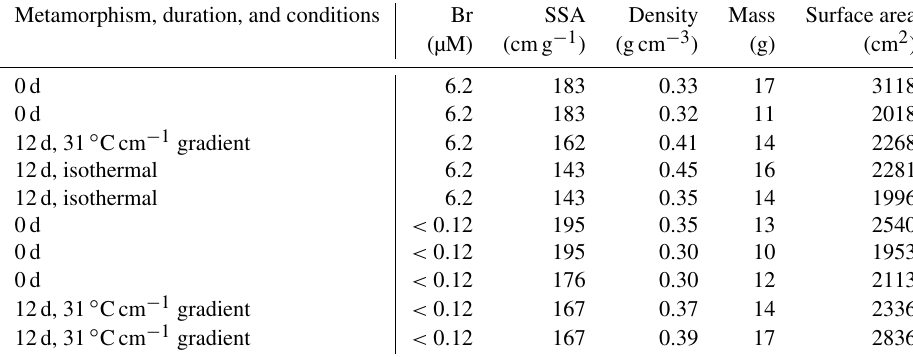
Table 1. Settings for the snow samples; the number of days gives the duration of metamorphism. Br denotes the concentration of bromide as derived by ion chromatography; SSA is the specific surface area as derived from the microCT scans with an typical error of ± 6% (Kerbrat et al., 2008). The density was derived based on the weight of the snow sample and the volume of the sample holder. The mass denotes the amount of snow during the ozone exposure experiments, and the surface area denotes the total surface area of the snow during the ozone exposure experiments. The experiments with added bromide and an average of the five experiments with no added bromide are shown in Fig. 1 and discussed in this work.